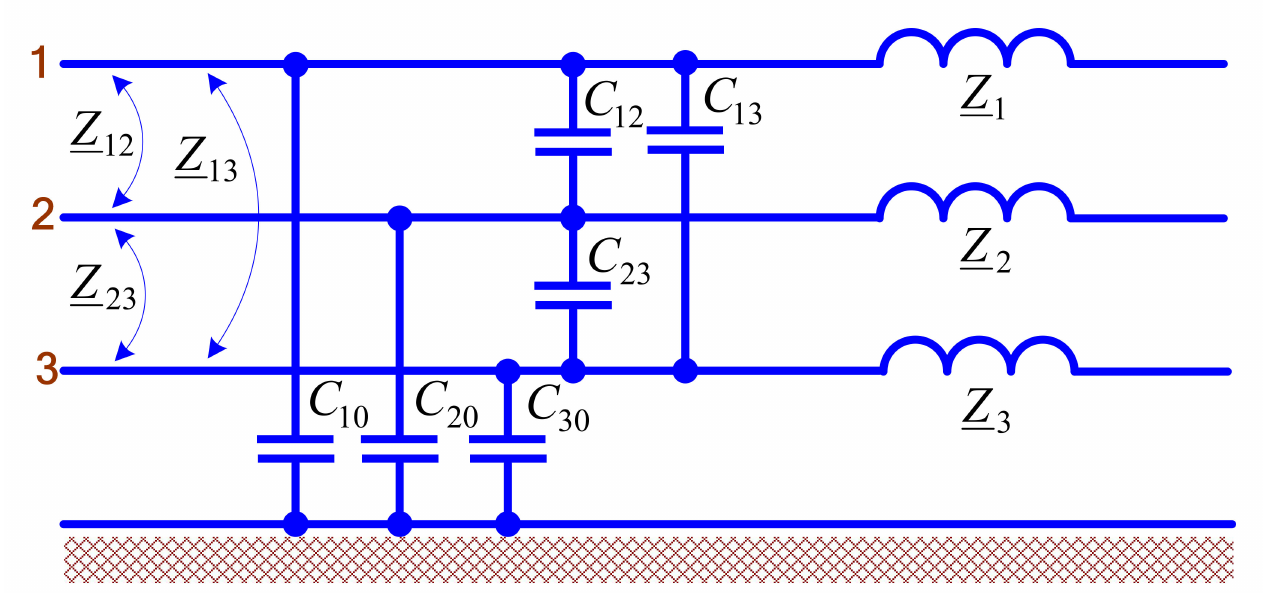
Figure 5. Original circuit of the power transmission line. Phase coordinates are the most natural description of three-phase power systems.